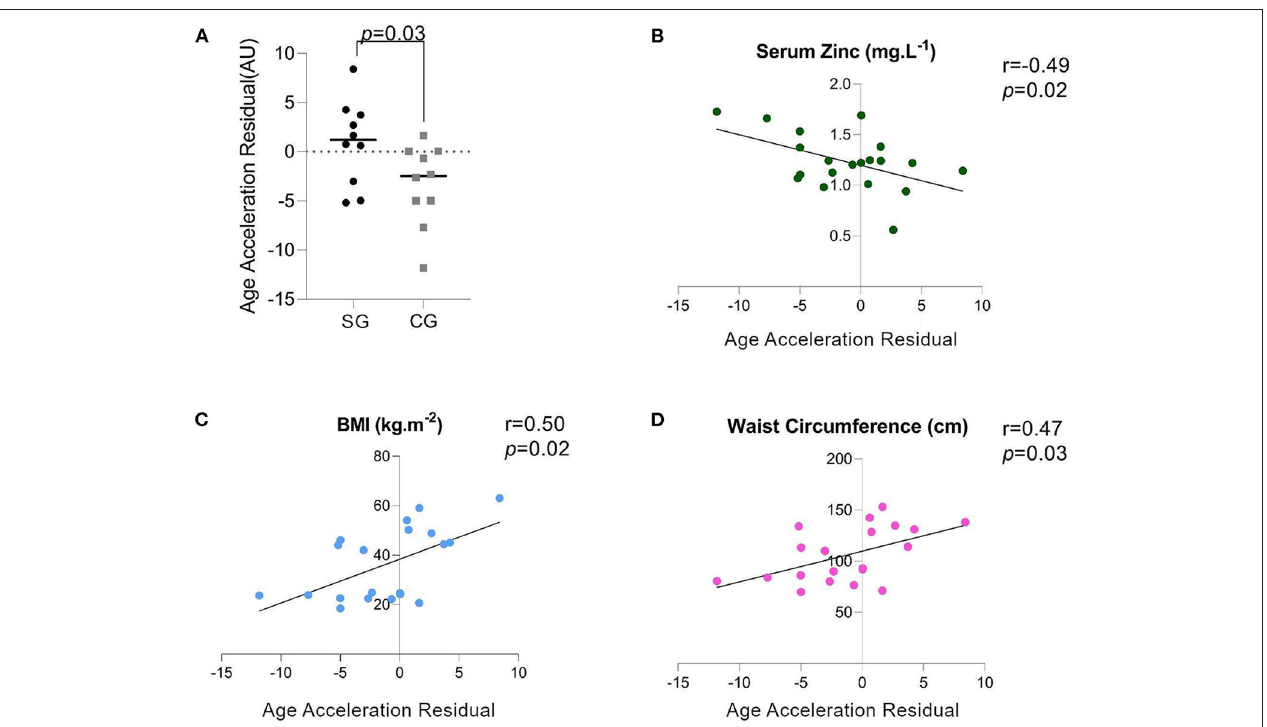
FIGURE 3 | (A) Gene Ontology Enriched Terms performed on Webgestalt Web Tool, (B) Venn Diagram of all retrieved differentially methylated regions (DMRs) from the Champ algorithm.